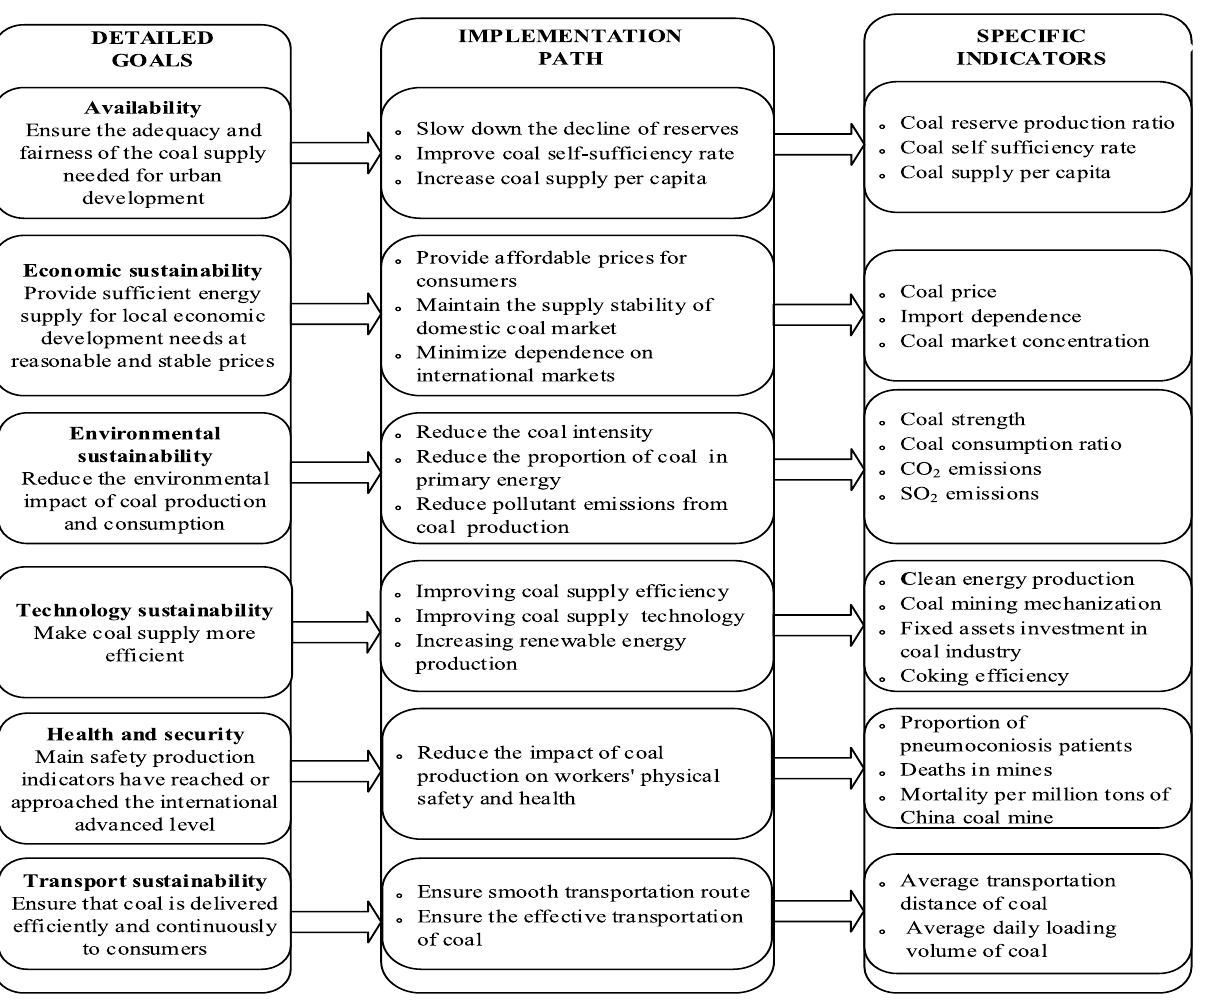
Frontiers in Energy Research |